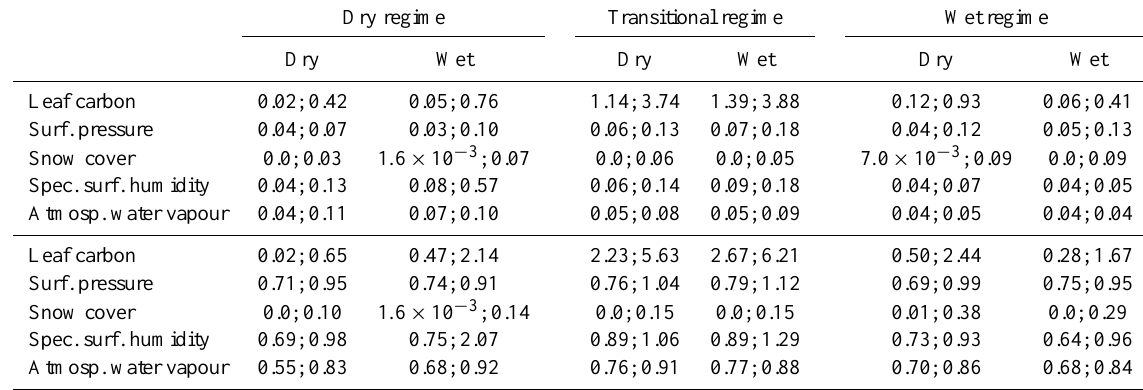
Table 6. Range of area-weighted mean values of τ 0 (upper part) and τ max (lower part) in months for different soil moisture regimes and initializations. The semicolon separates minimum and maximum values occurring for different seasons and